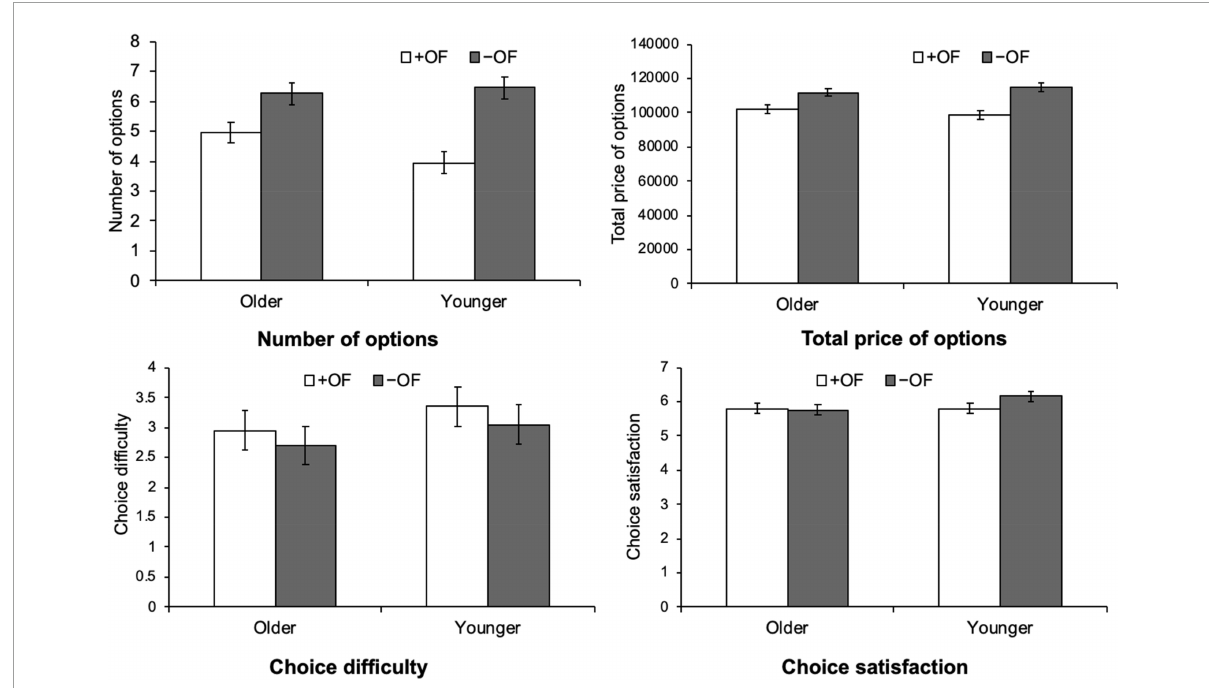
FIGURE1 Age differences in the effects of framing on the number of options chosen, total price, choice difficulty, and choice satisfaction for the travel package.